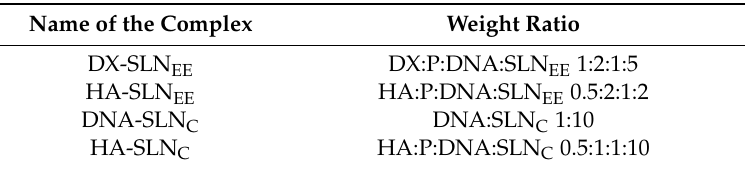
Table 1. Weight ratios of the